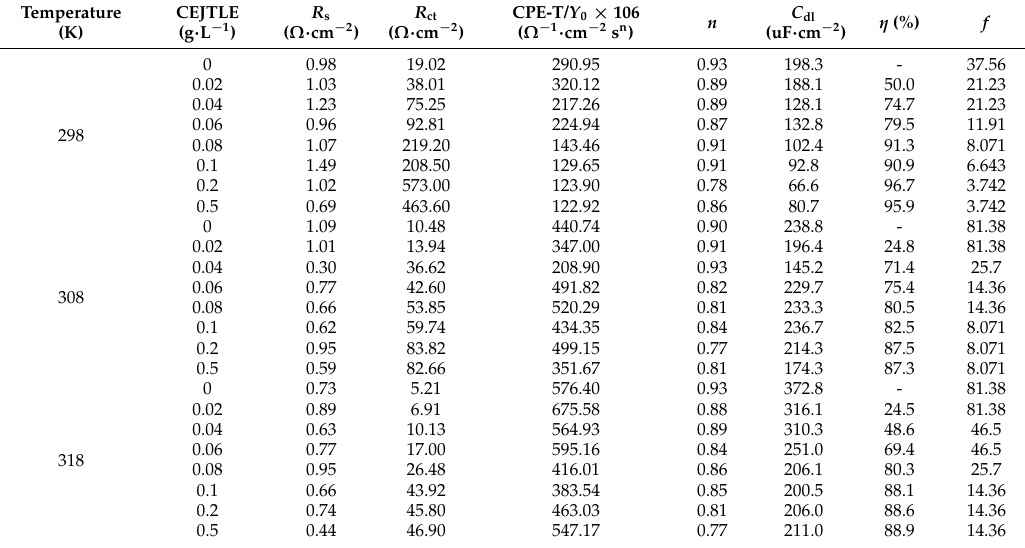
Table 2. The impedance parameters for C-steel in 1 M HCl solution with and without various concentrations of EJTLE at different